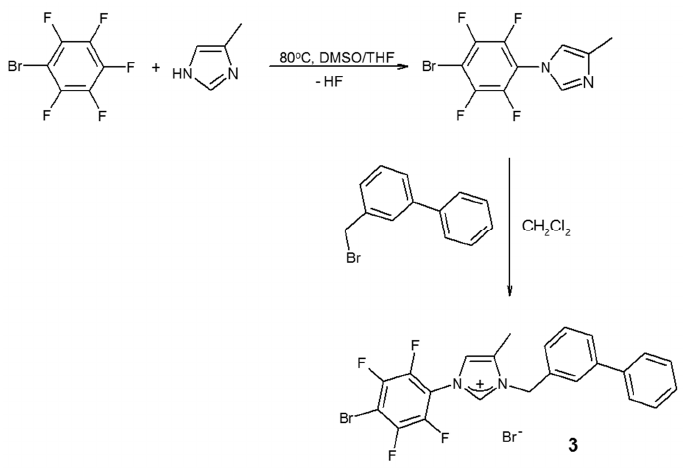
Table 1. Cation-anion interactions in the crystal structure of salt 3.